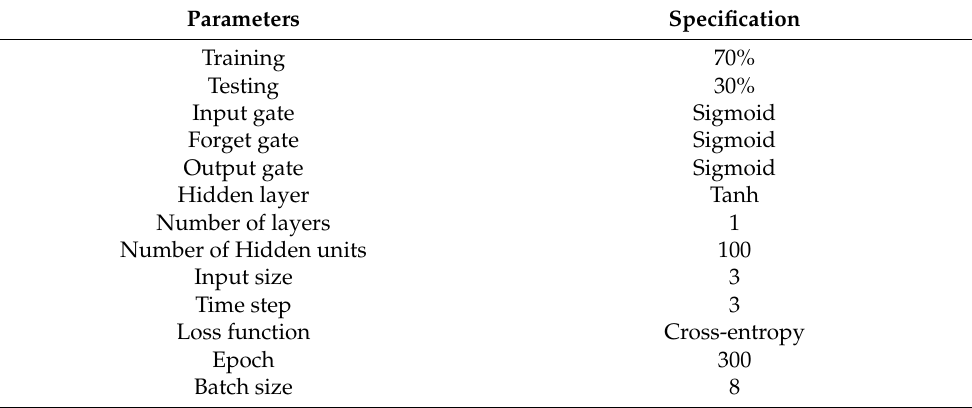
Table 2. LSTM Network structure parameters.